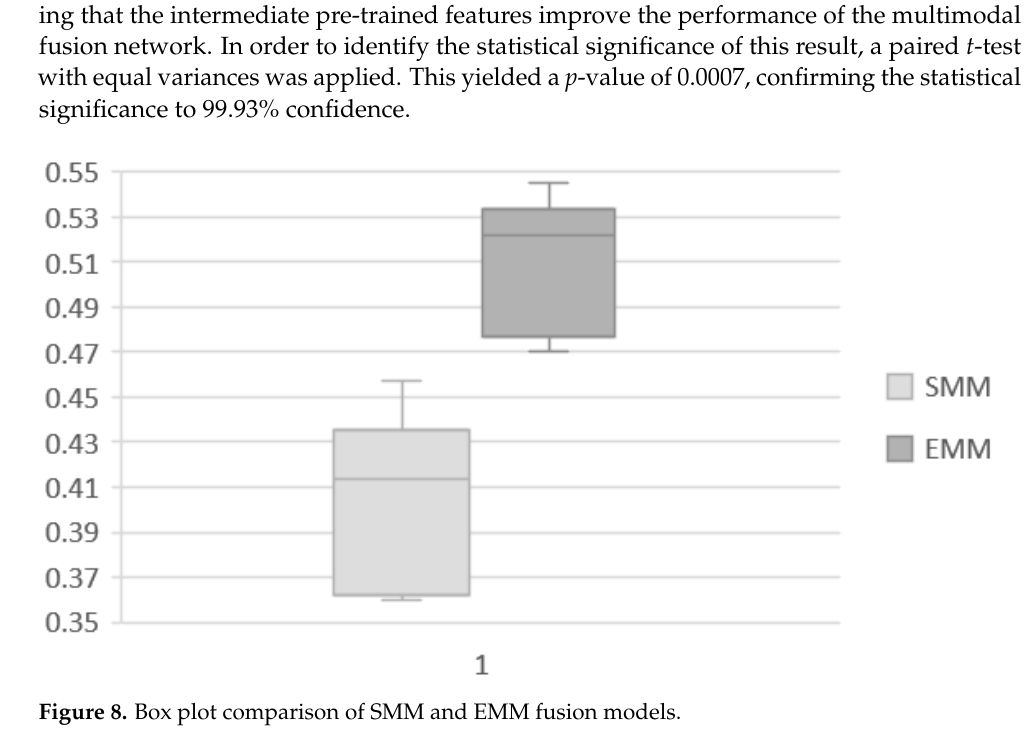
Figure 8. Box plot comparison of SMM and EMM fusion models.